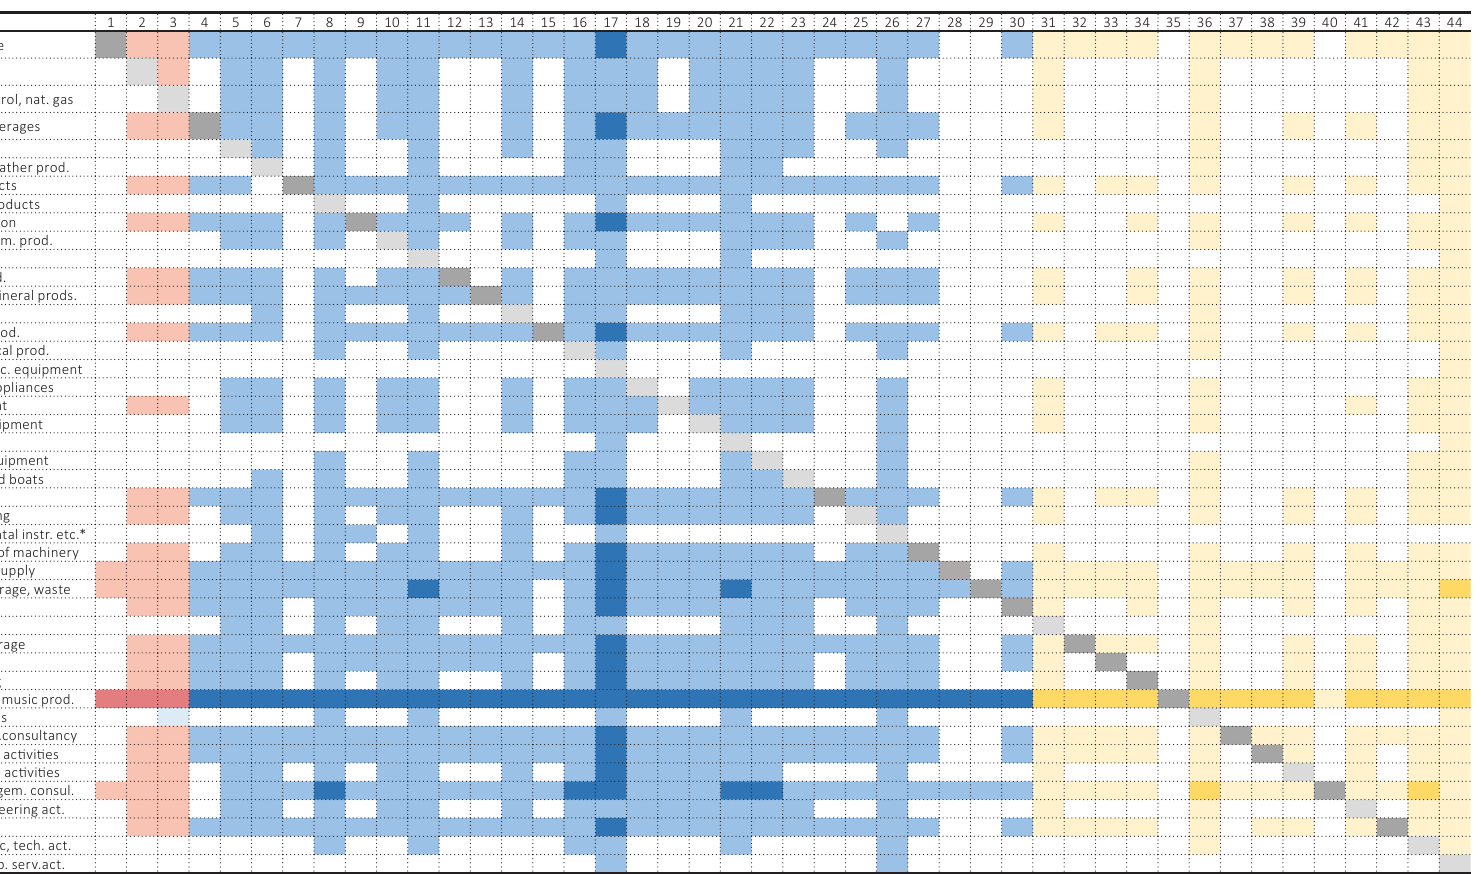
Table 4. Comparison growth-rate analysis of R&D expenditure by performing industry, percentage change (compare to other industries)